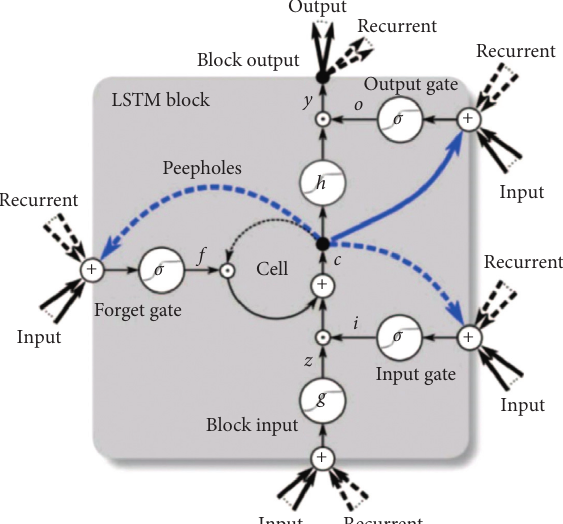
Figure 3: LSTM storage unit with